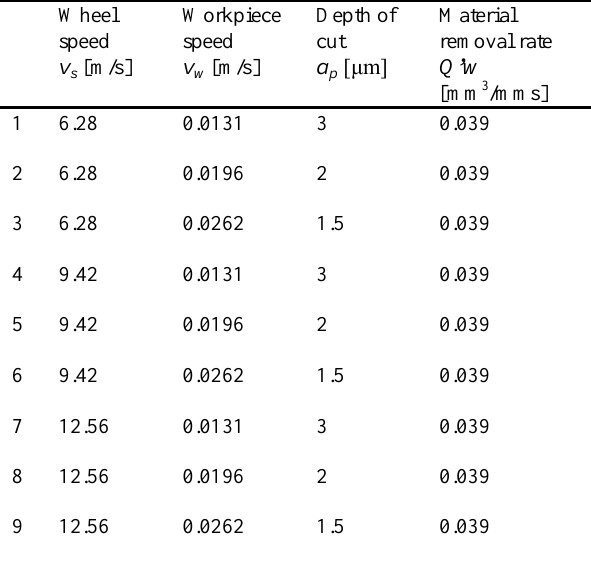
Table 2. Different process parameters for the micro-grinding.